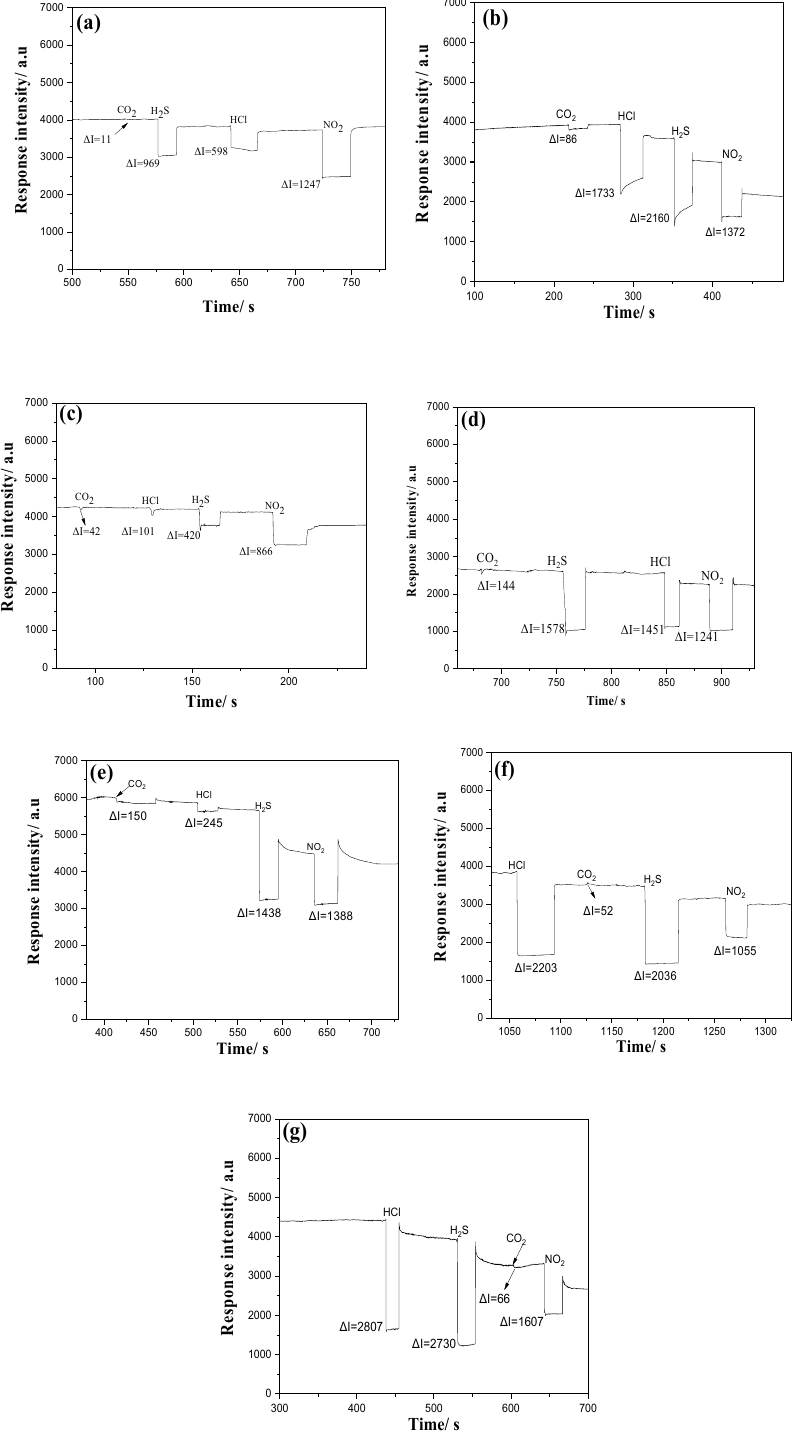
Figure 9. Response curve in optical waveguide (670 nm) with porphyrin film exposed to acidic gases ( a ) TPP, ( b ) TAPP, ( c ) TBPP, ( d )TCPP, ( e ) THPP, ( f ) TMPP, ( g ) TSPP film.